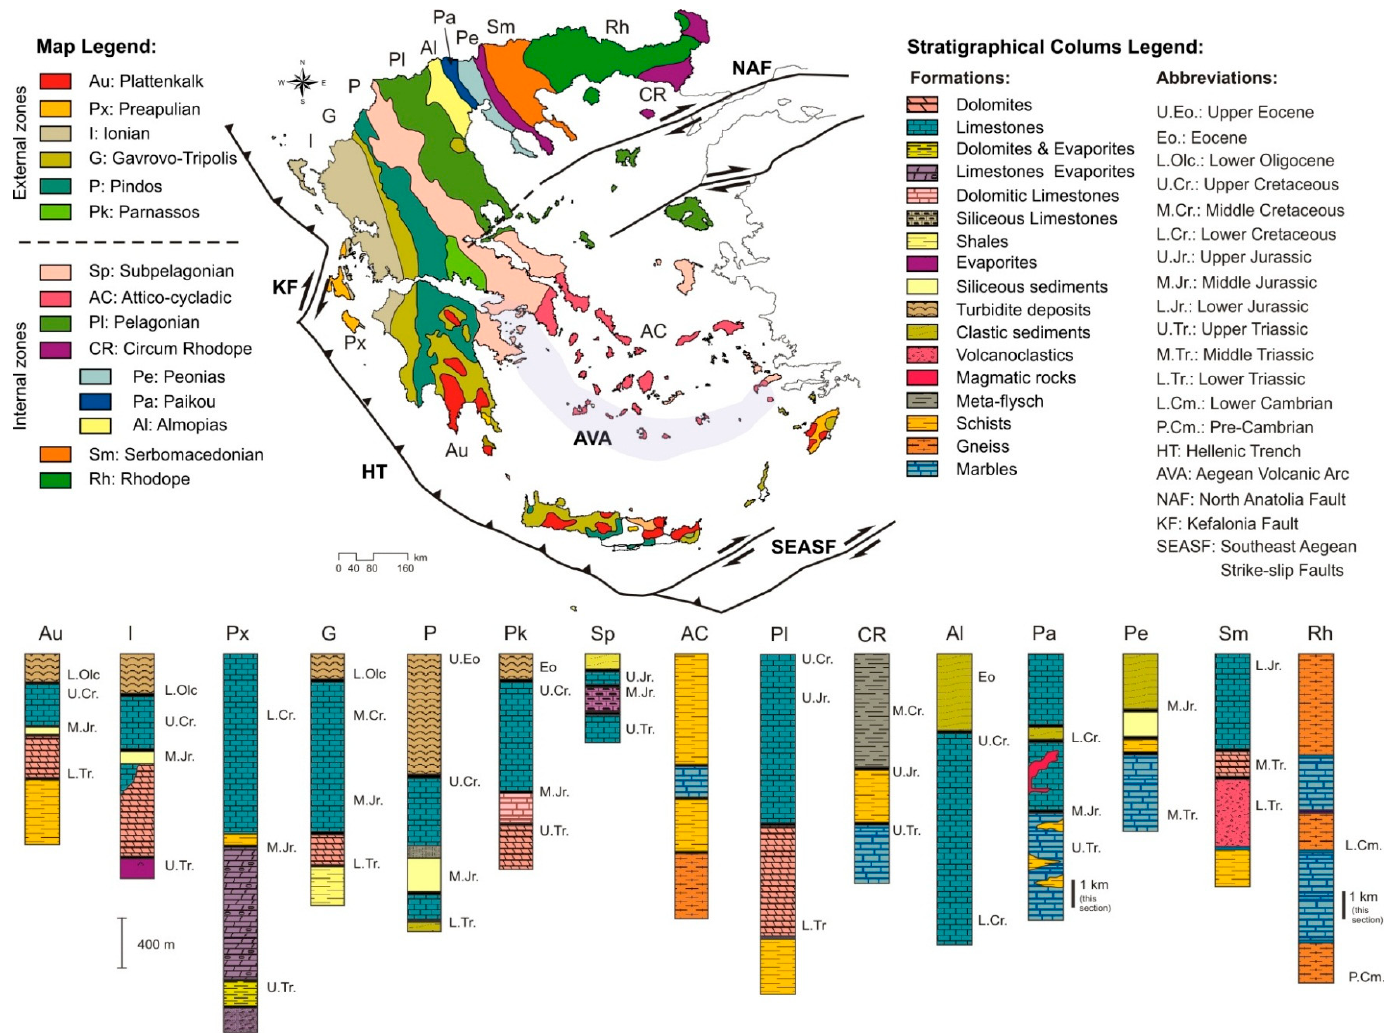
Figure 1. Geographic distribution and lithostratigraphic columns of the “isopic” zones of Greece [19].